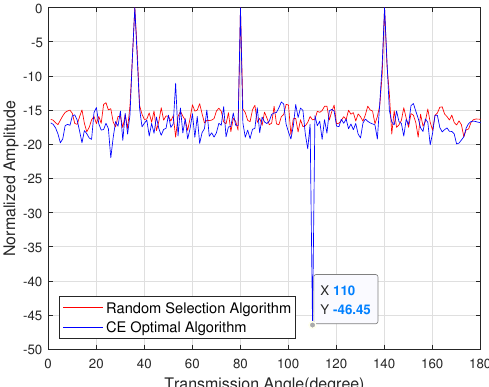
Figure 8. The sidelobe energy of the emission pattern with the known channel state information of the